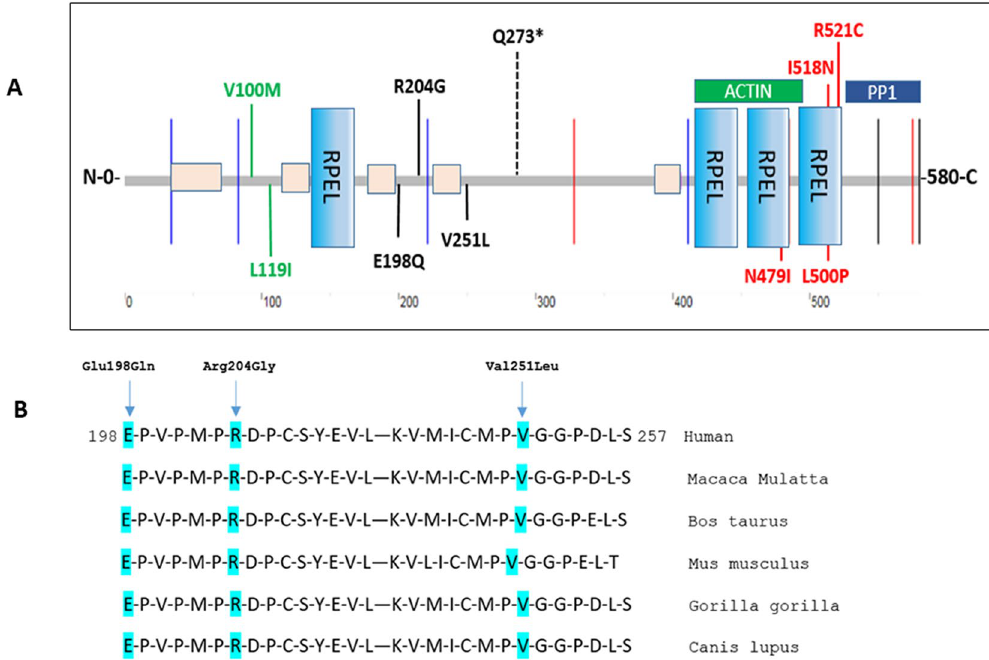
Figure 3. A. PHACTR1 protein structure. In black PHACTR1 coding mutations detected in our SVD- CADASIL-like cohort and in the BCCAS-MCAO mouse cohort (dashed line) (Given the high level of analogy between the human and mouse PHACTR1 protein, we adopted the same human protein to show the coding variants detected both in patients and mice). In green PHACTR1 coding mutations detected in elderly neuropathologically proven controls (478 controls > 60 years, HEX DATABASE). In red, PHACTR1 coding pathogenic mutations in RPEL 3 and 4 domains, causative for West syndrome and other neurodevelopmental disorders 11 . PHACTR1 protein structure has been adapted from String version 11.0 (https ://strin g-db.org/). ( B ) PHACTR1 partial protein sequence, displaying a high degree of conservation across different species for Gly-198, Arg-204 and Val-251 amino-acids, where we detected PHACTR1 coding mutations in our SVD- CADASIL-like cohort. ( C , D ) Phactr1 in mouse brain. ( C ) Coronal mouse brain section showing Phactr1 exclusive expression in neurons and to a significant lesser extent in the white matter ( D ). Scalebar A = 1000 μm and B = 200 μm.